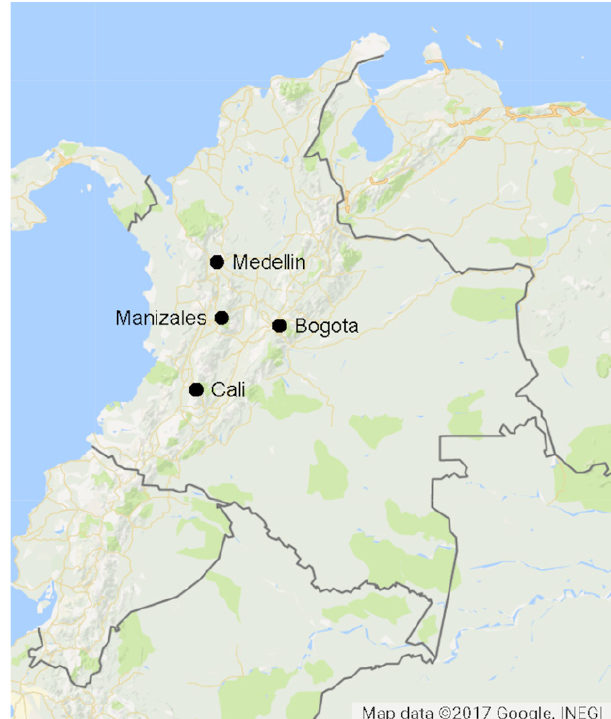
Figure. Map of Colombia. Emergency medicine residencies in Colombia are found in the three largest cities, Bogotá, Medellin and Cali as well as in the mid-size city of